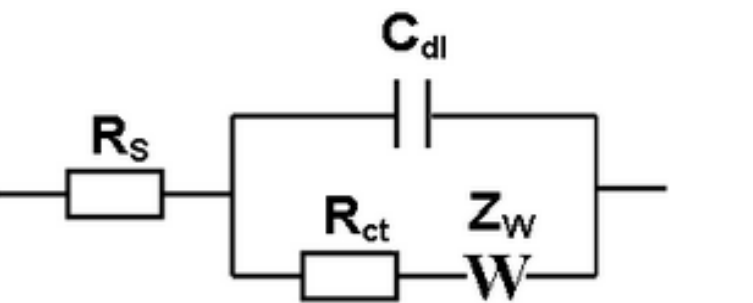
Figure 1. Randles equivalent circuit, where R S is the solution resistance, R ct is the charge-transfer resistance, C dl is the double-layer capacitance, and Z W is the Warburg impedance.